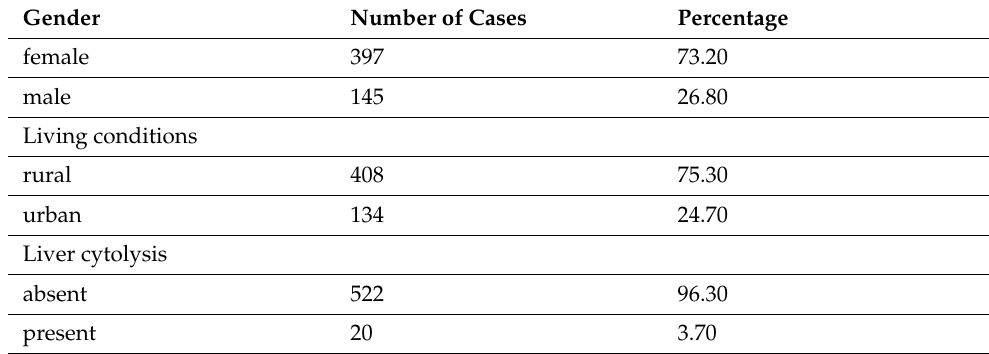
Table 4. Structure of the group of patients with H. pylori infection.